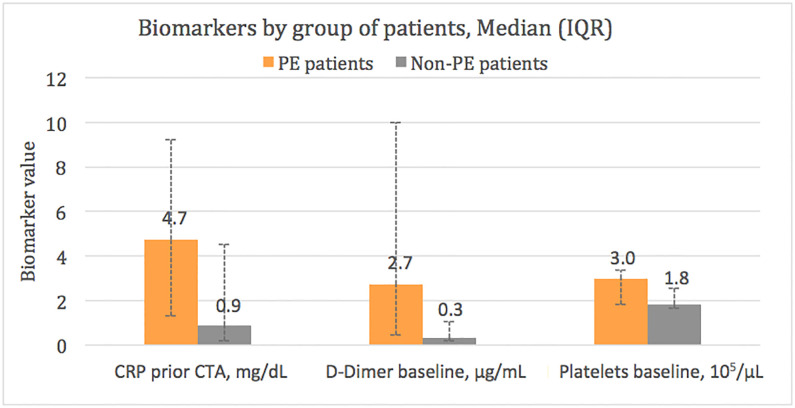
Significant biomarker differences between PE and non-PE populations.Abbreviations: PE, pulmonary embolism; IQR, interquartile range; CTPA, computed tomography pulmonary angiography.